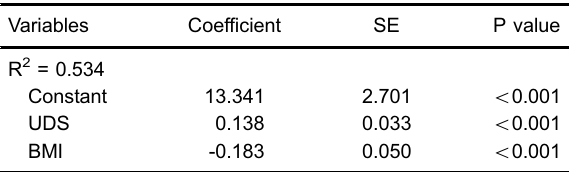
Figure 3. Bland-Altman graphical analysis of the differences between peak VO 2 of the cardiopulmonary exercise test (CPX) and the two-minute step test (2MST). Table 3. Oxygen uptake (VO 2 ) predictive model considering number of up-and-down step cycles (UDS) during the two-minute step test (2MST) and body mass index